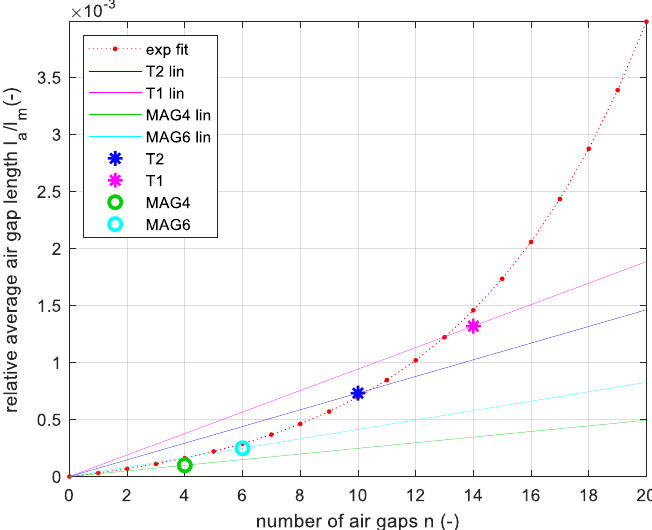
Figure 17. Relative average air gap length l a / l m in the function of a number of parasitic air gaps n : T2, T1, MAG4 and MAG6 measurement (stars / circle), the corresponding idealized reluctance model (solid lines), and the relative average air gap length calculated based on the proposed exponential interpolation (red dashed line).